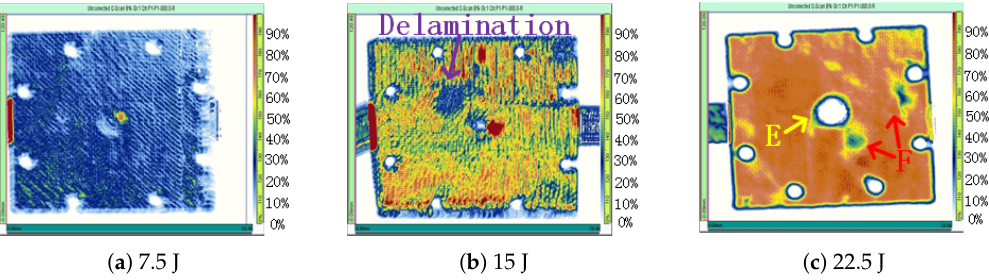
Figure 9. UT amplitude images of the BFRP laminates.